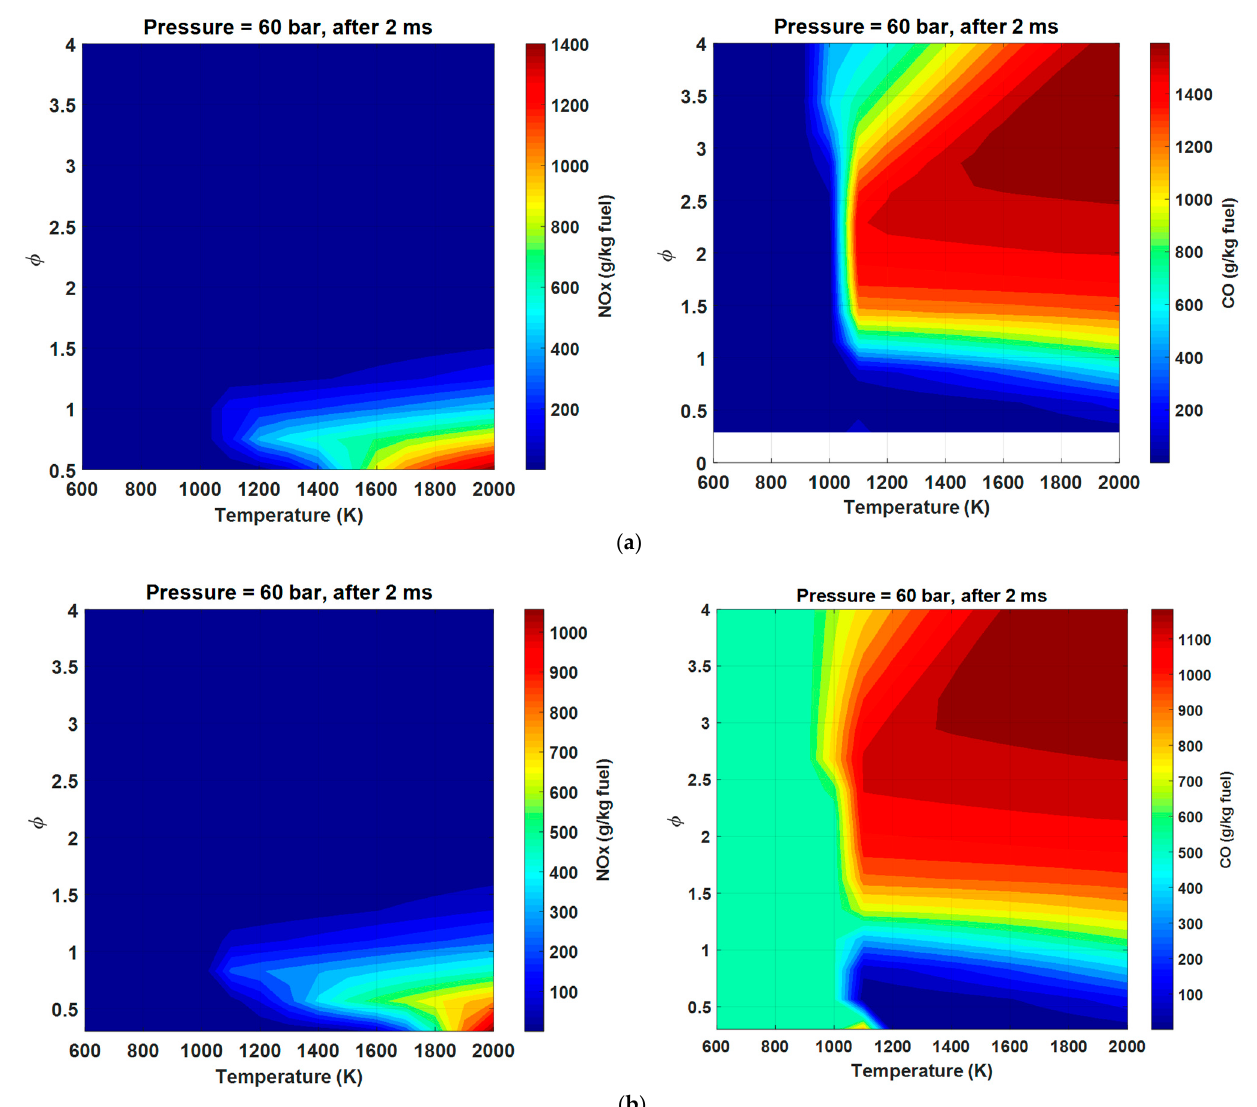
Figure 14. NOx and CO yield at 2.0 ms obtained from a homogeneous reactor simulation of: ( a ) 80%CH 4 /20%H 2 ; ( b ) 40%CH 4 /30%H 2 /30%CO.